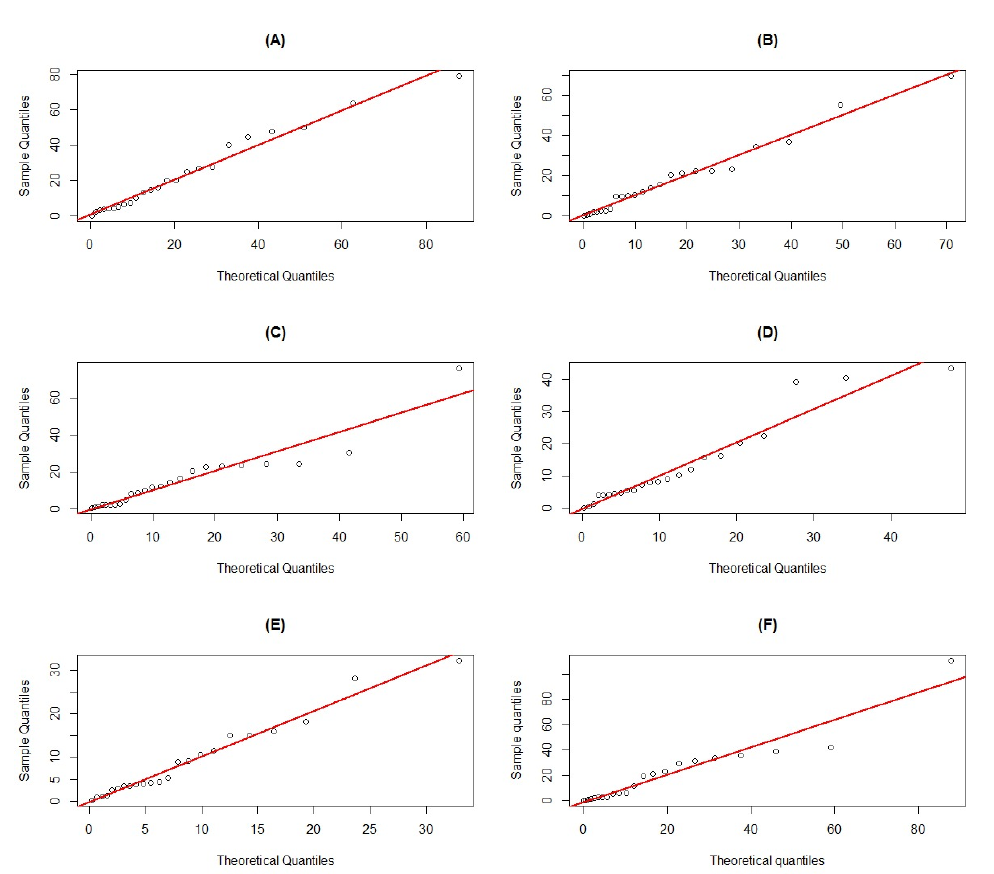
Figure 7. Q-Q plots of the nonzero part of the daily rainfall datasets from the six regions in